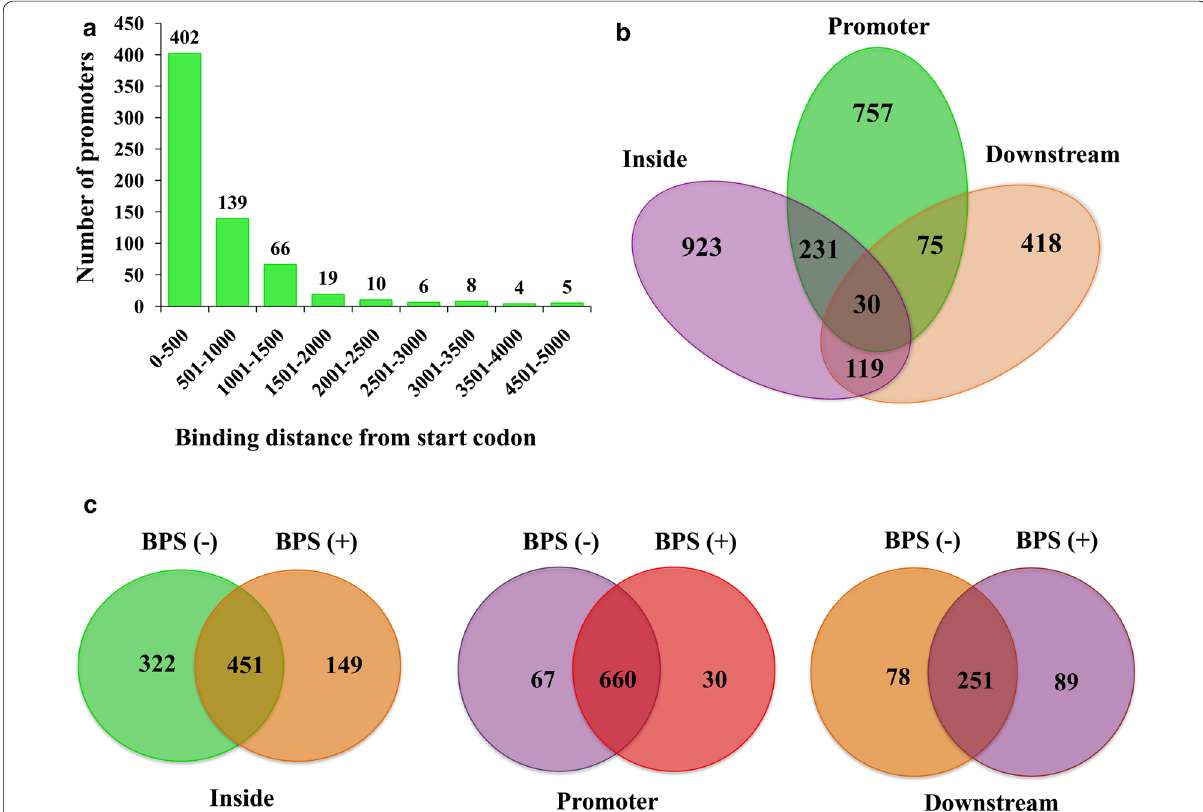
Fig. 1 Number of promoters. a Binding sites of Hsf1, as determined by ChIP-on chip, were mapped to display their distance from the start codon of the closest genes. Number of promoters for each distance is represented in this histogram. The X-axis represents the binding distance from the start codon and the Y-axis denotes the number of genes. b Number of binding sites of Hsf1 seen on the inside, promoter and downstream regions of genes. Common genes are represented in the overlapping regions of the diagram. c Comparison of number of binding sites in wildtype and iron deprived cells in inside, promoter and downstream